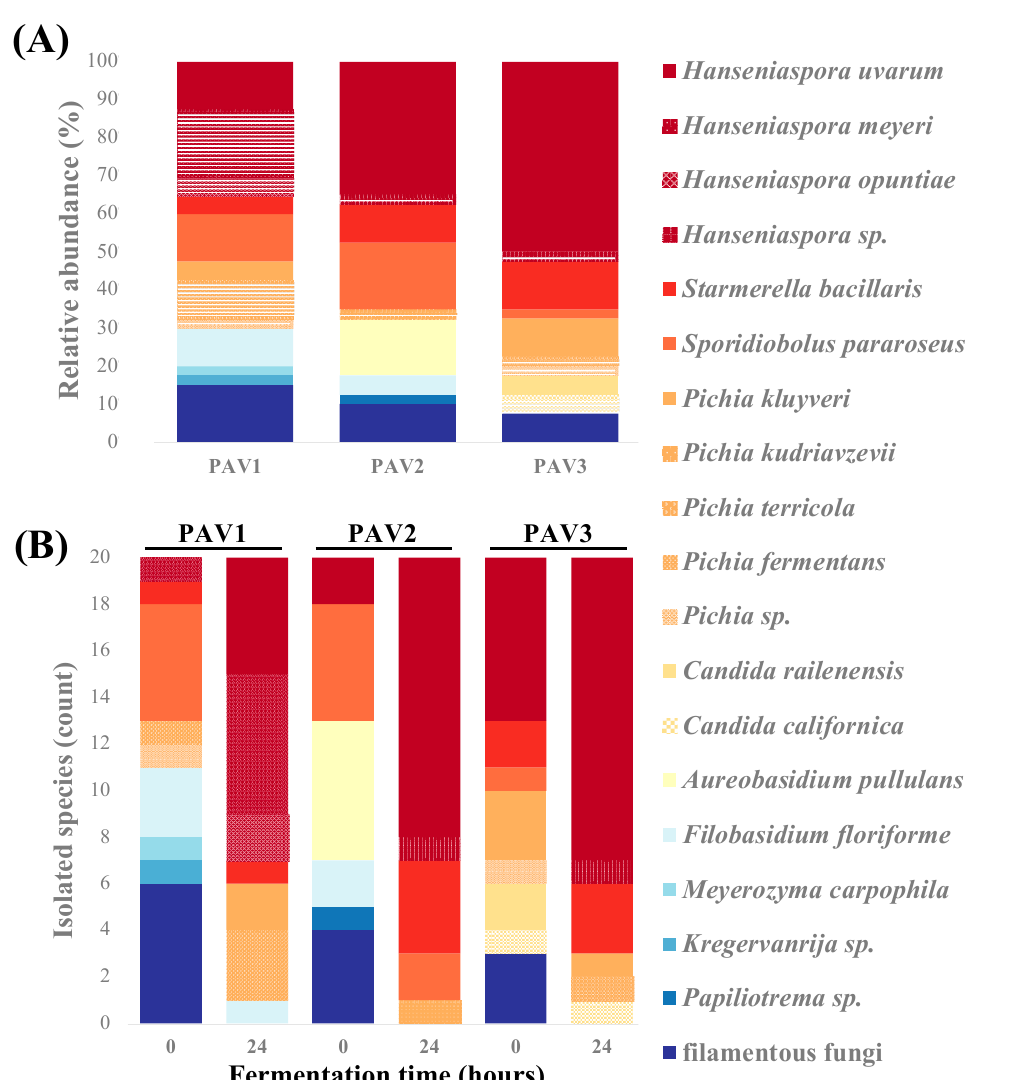
Figure 2. Main contributing fungal species during spontaneous fermentation of Chambourcin grape must. ( A ) Relative proportion of identified fungal species (%) from 120 randomly selected colonies (20 isolates/sampling time; 40 isolates from each location) obtained during spontaneous fermentation. ( B ) Fungal species identified on Dichloran Rose Bengal Chloramphenicol (DRBC) agar plates at 0 and 24 h (20 colonies/time point).